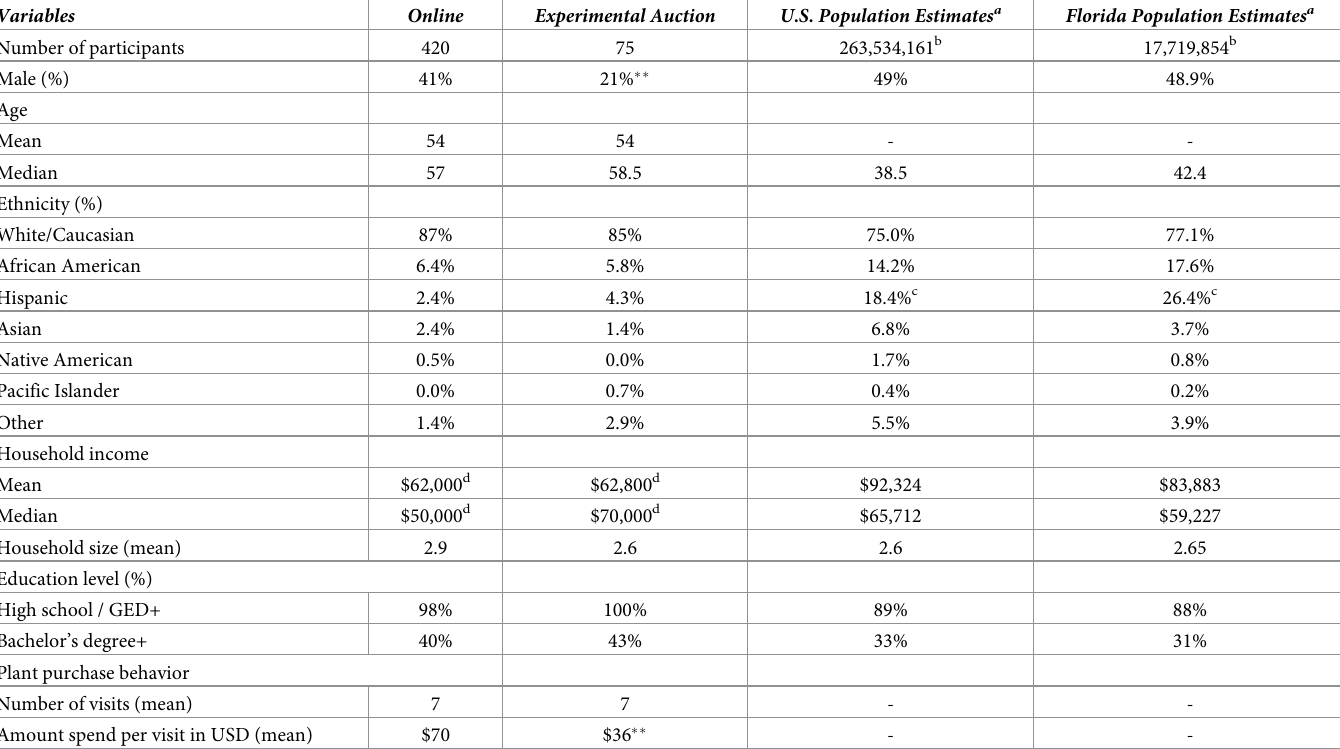
Table 2. Descriptive summary